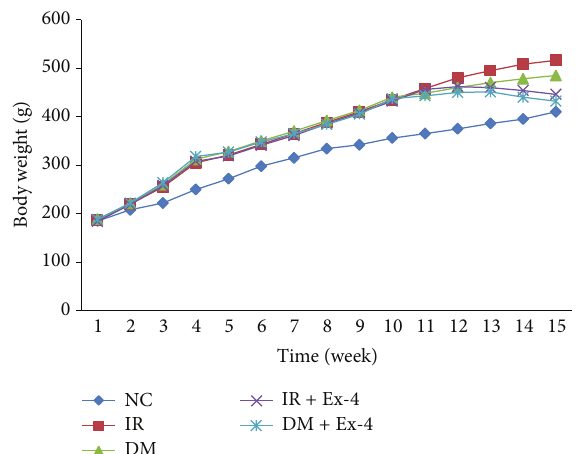
Figure 1: The curve of rats’ body weight. NC: normal control group; IR: insulin resistance group; DM: diabetes mellitus group; IR + Ex- 4: insulin resistance plus Exendin-4 treatment group; DM + Ex-4: diabetes mellitus plus Exendin-4 treatment group.